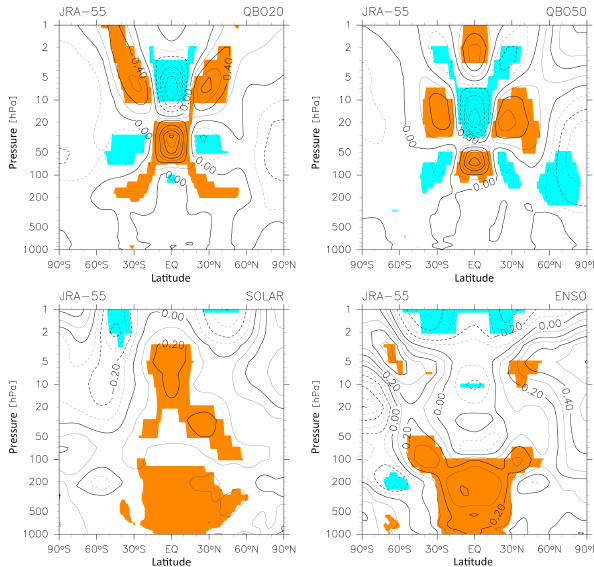
Figure 6. As in Fig. 1 but for the period